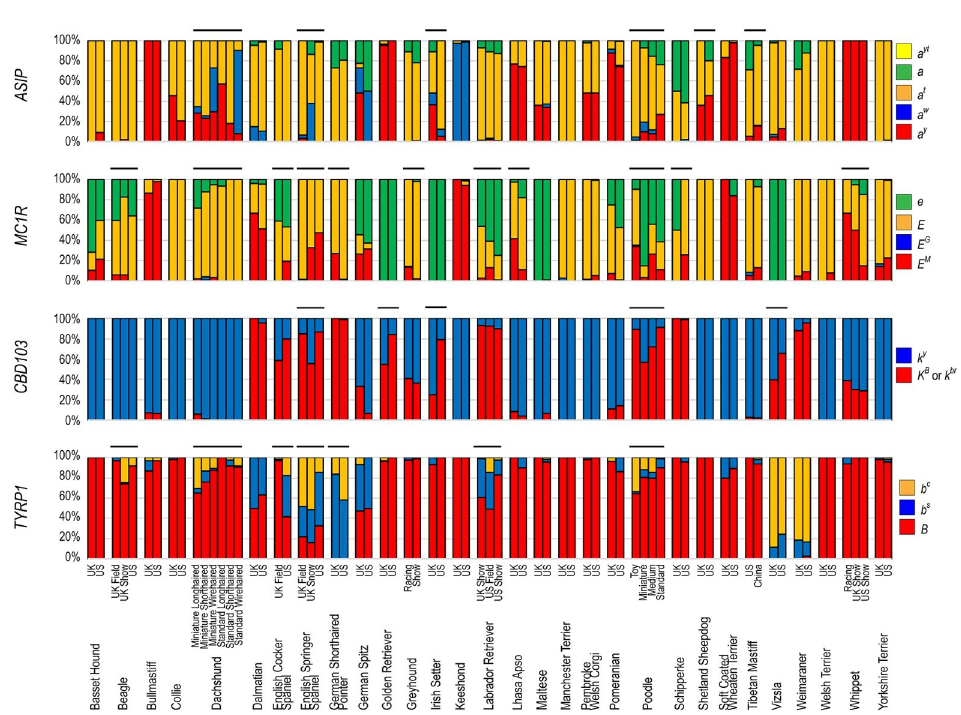
Fig 2. Allele frequencies for MC1R , ASIP , TYRP1 , and CBD103 across same-breed populations. Horizontal black bars indicate within-breed allele distributions that are significantly different (p � 0.00167).